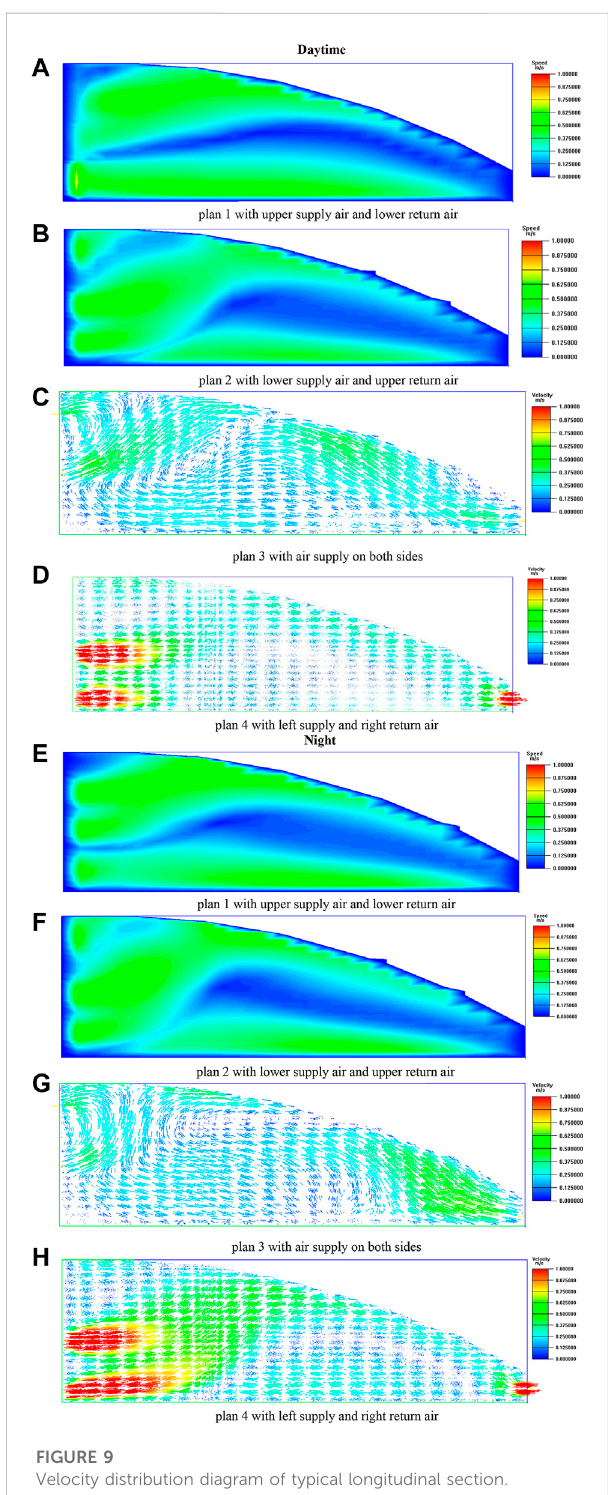
FIGURE 9 Velocity distribution diagram of typical longitudinal